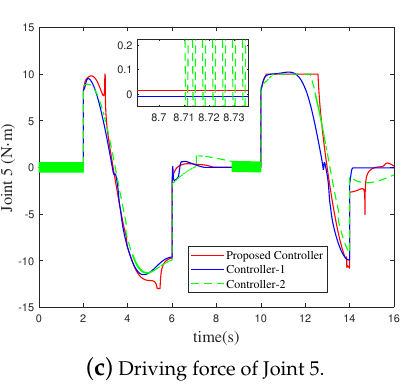
Figure 5. Driving force curves of the unilateral active joints under the three